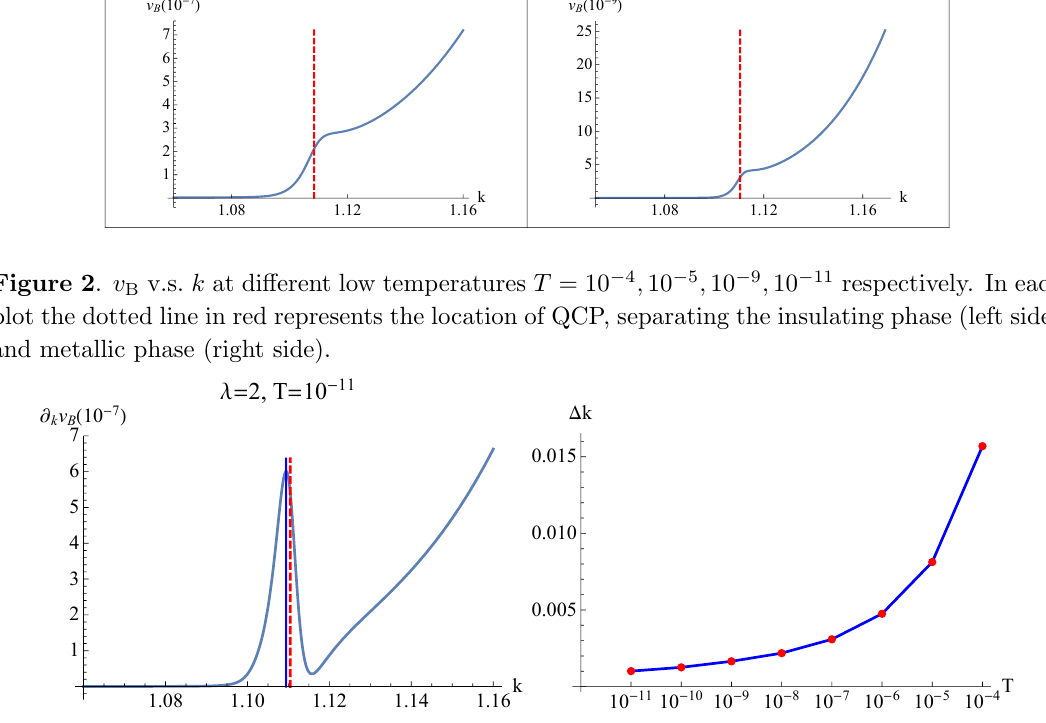
Figure 3 . The left plot is @ k v B v.s. k at T = 10 (cid:0) 11 , in which the red vertical line represents the position of the critical point while the blue line denotes the position of the local maximum of @ k v B . The right plot is for the temperature dependence of (cid:1) k